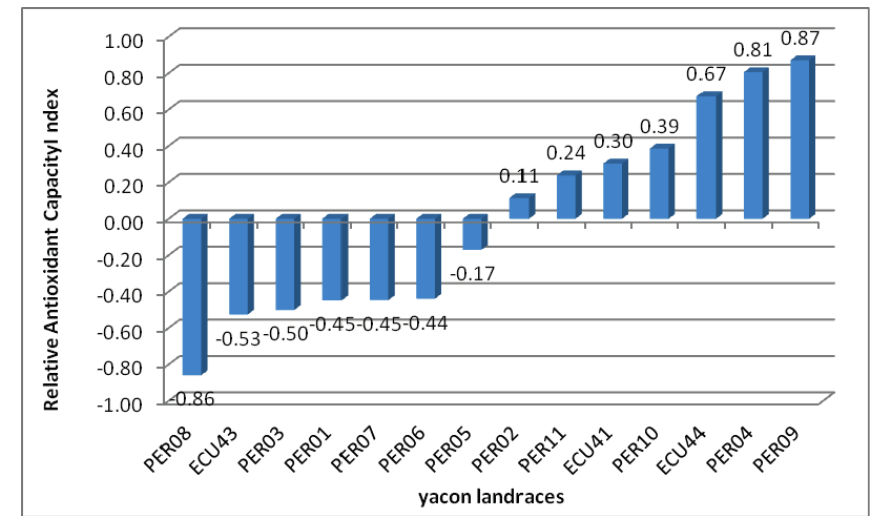
Figure 3. Relative antioxidant capacity index of investigated yacon